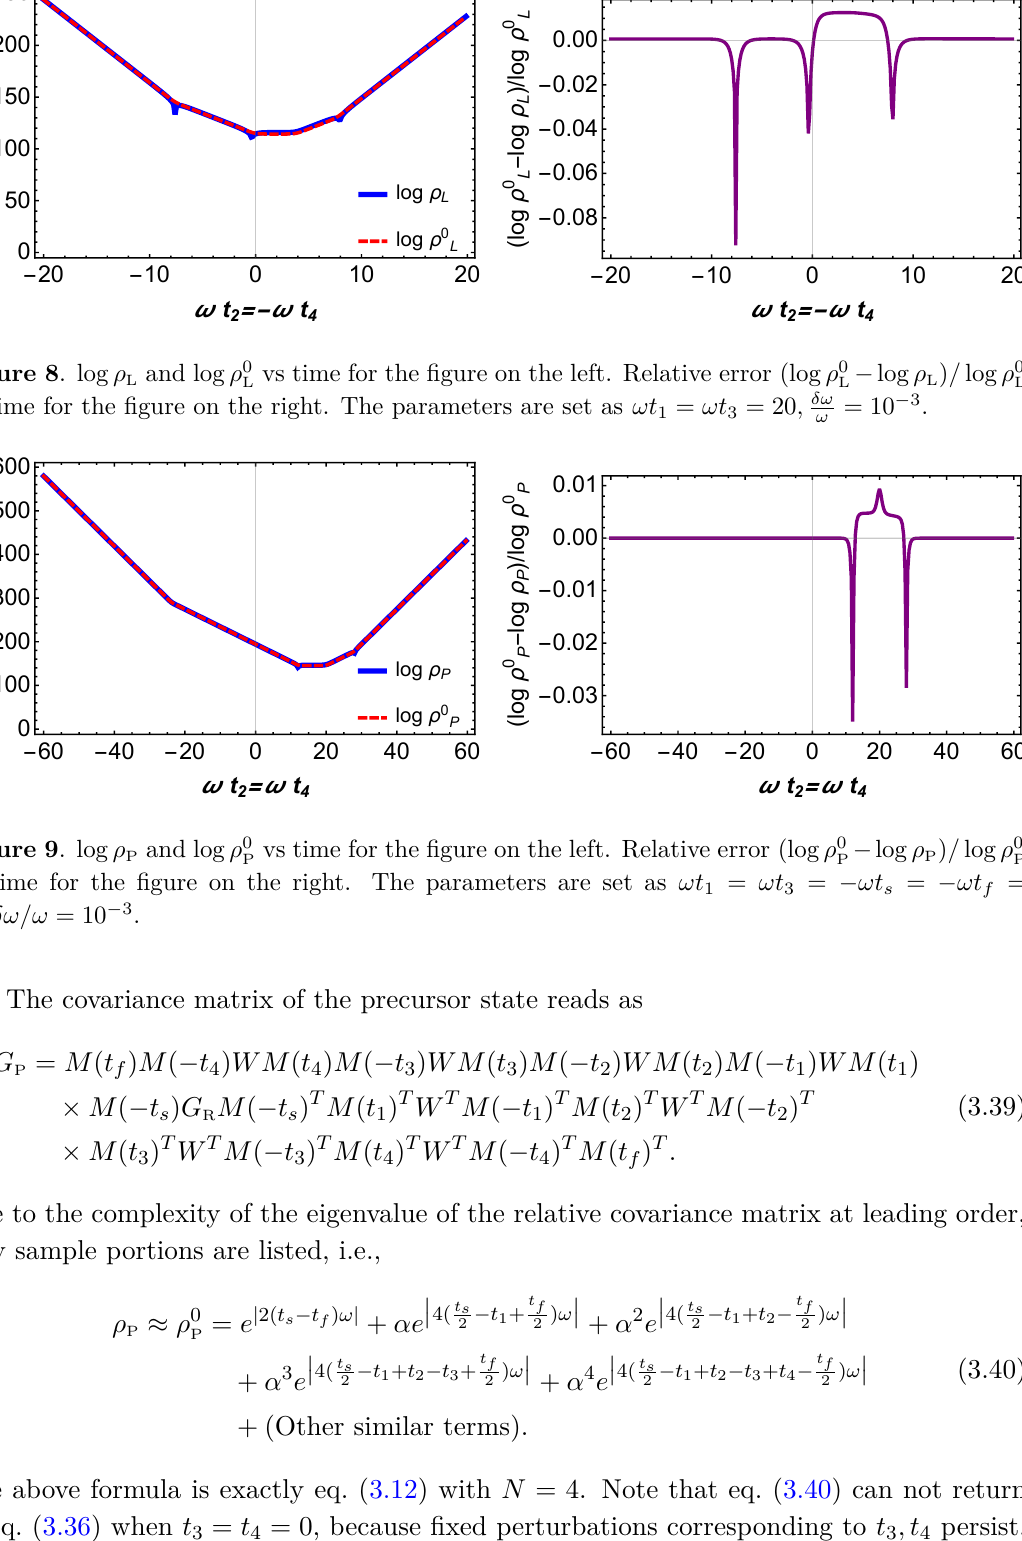
and log ρ 0 vs time for the figure on the left. Relative error (log ρ 0 L L